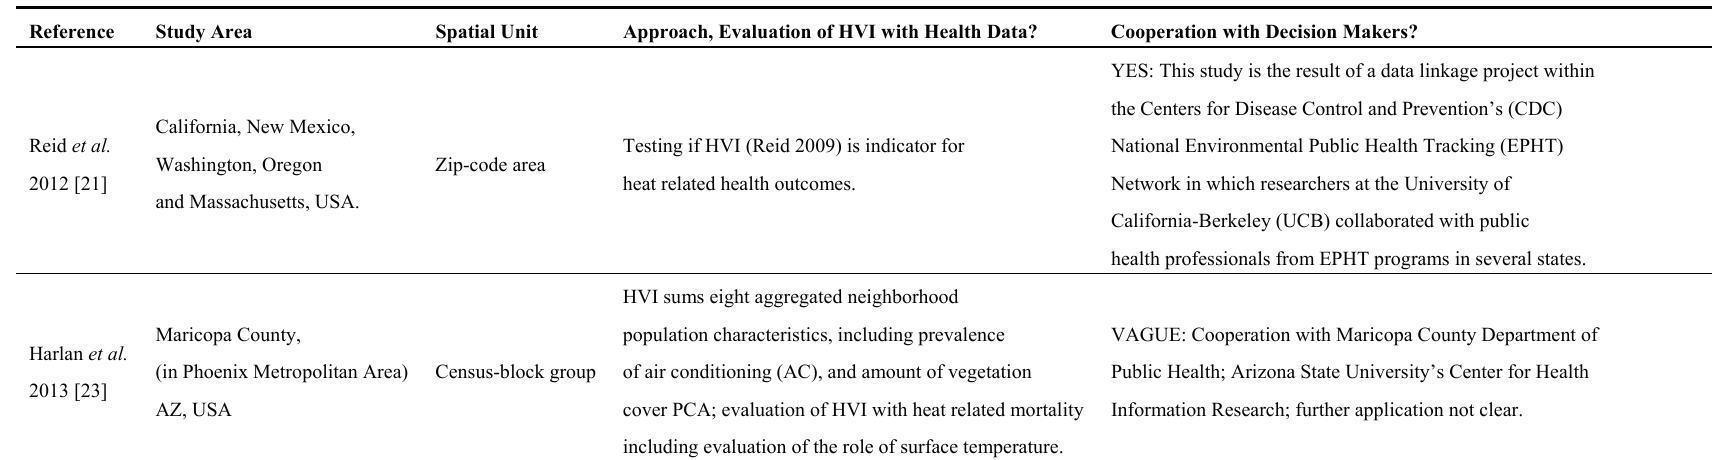
Table 2. Papers on “ a-priori ”/inductive heat vulnerability mapping using health data to test the